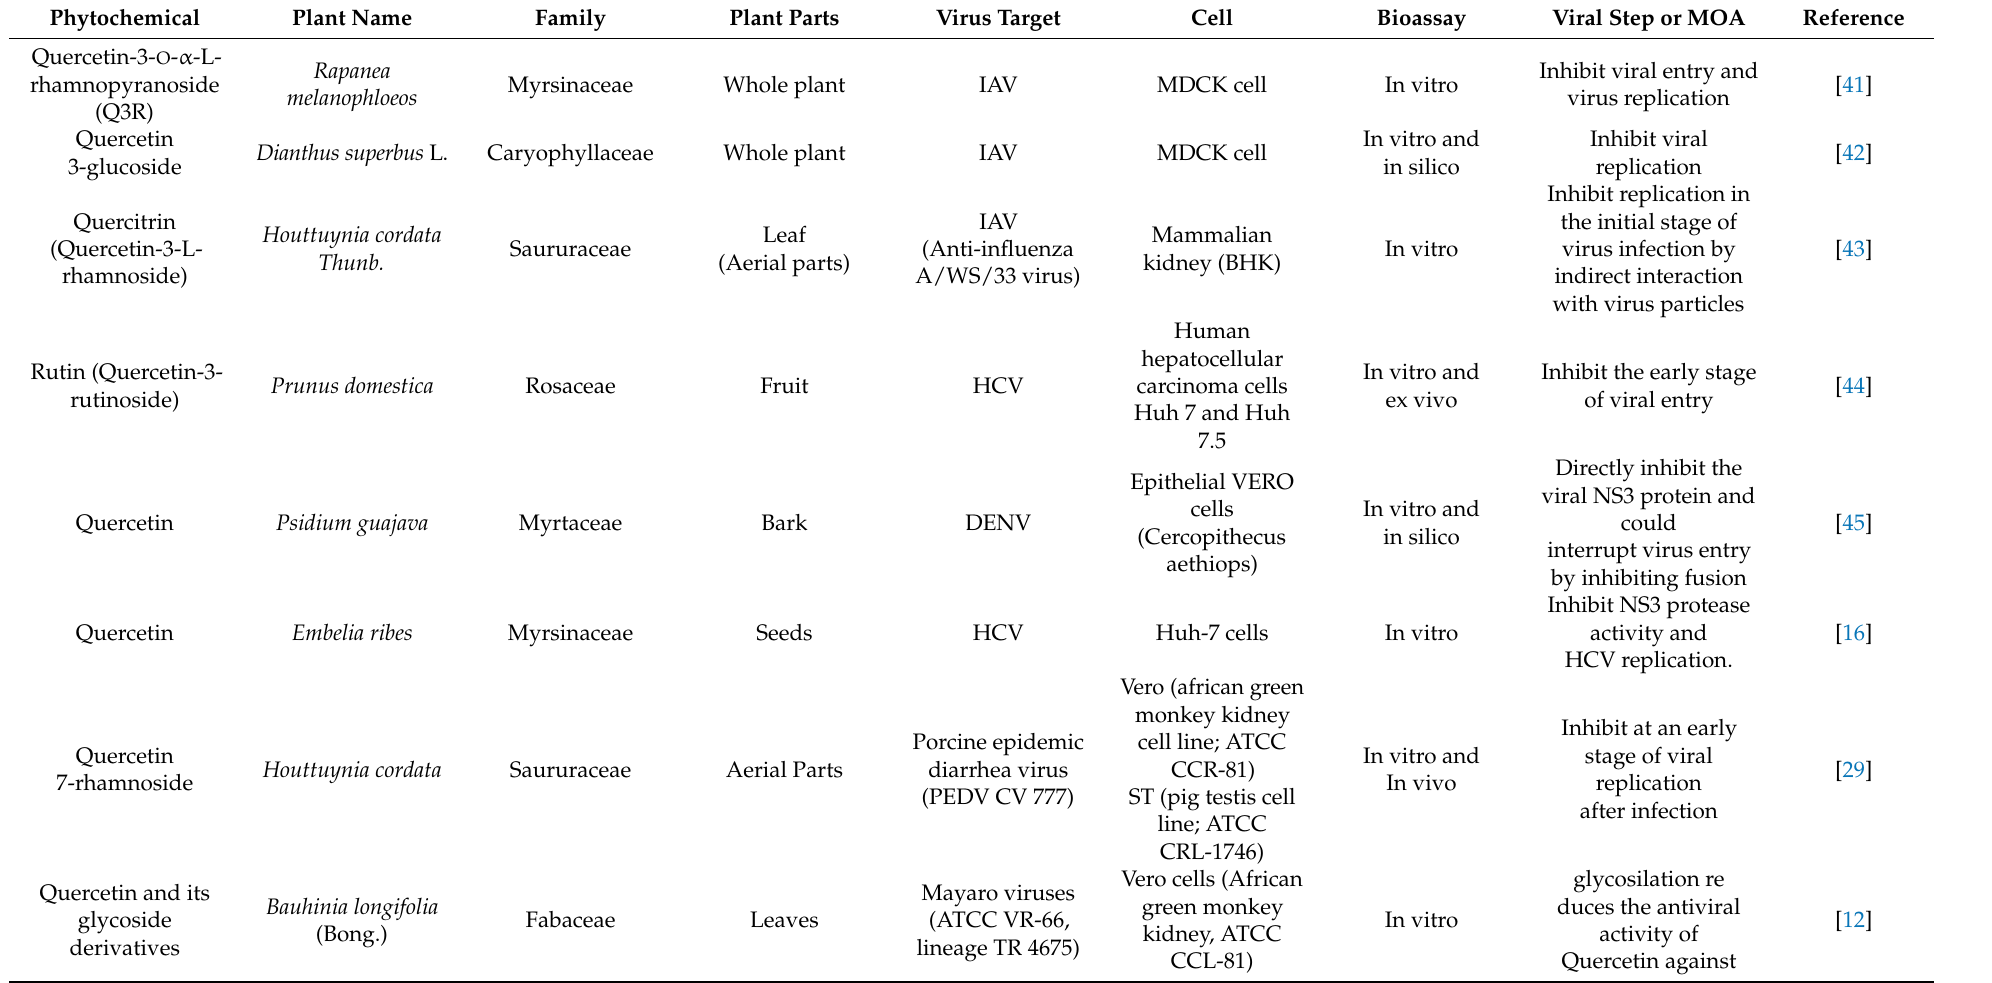
Table 1. Quercetin and its derivatives from different plant sources and their biological effects in various experimental